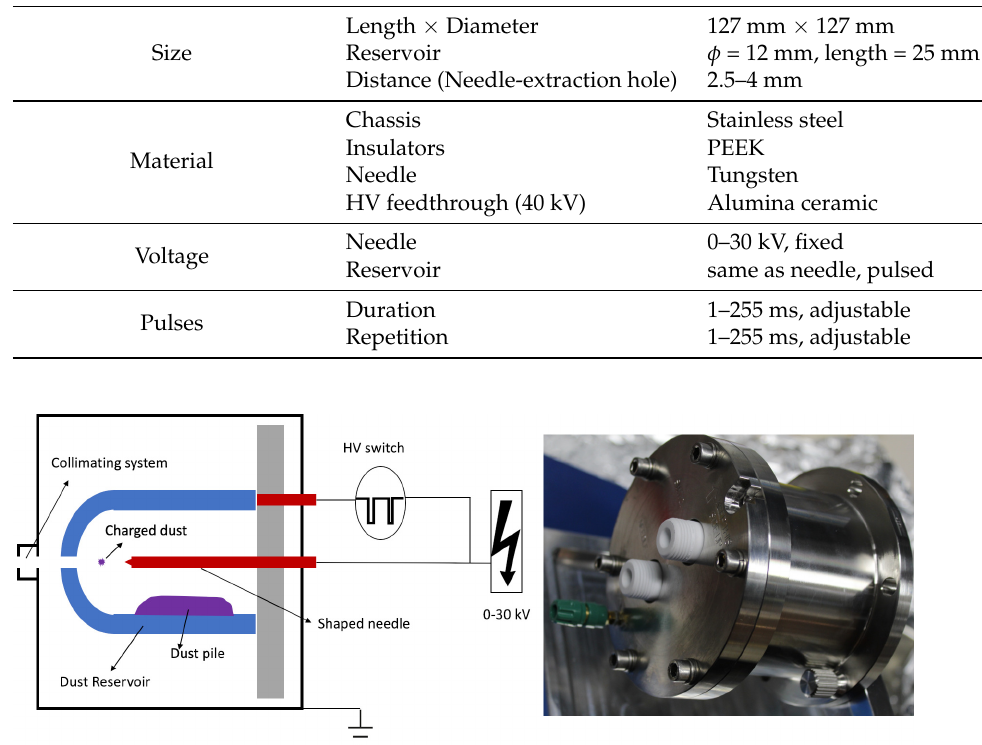
Figure 4. Schematic diagram and realistic picture of the new dust source. Dust particles are charged by contact with the reservoir surface. Charged particles will be levitated by the electrostatic force. Particles close to the exiting hole and the needle will be fired out. The potential drops to ground (0 V) on the extraction plate.